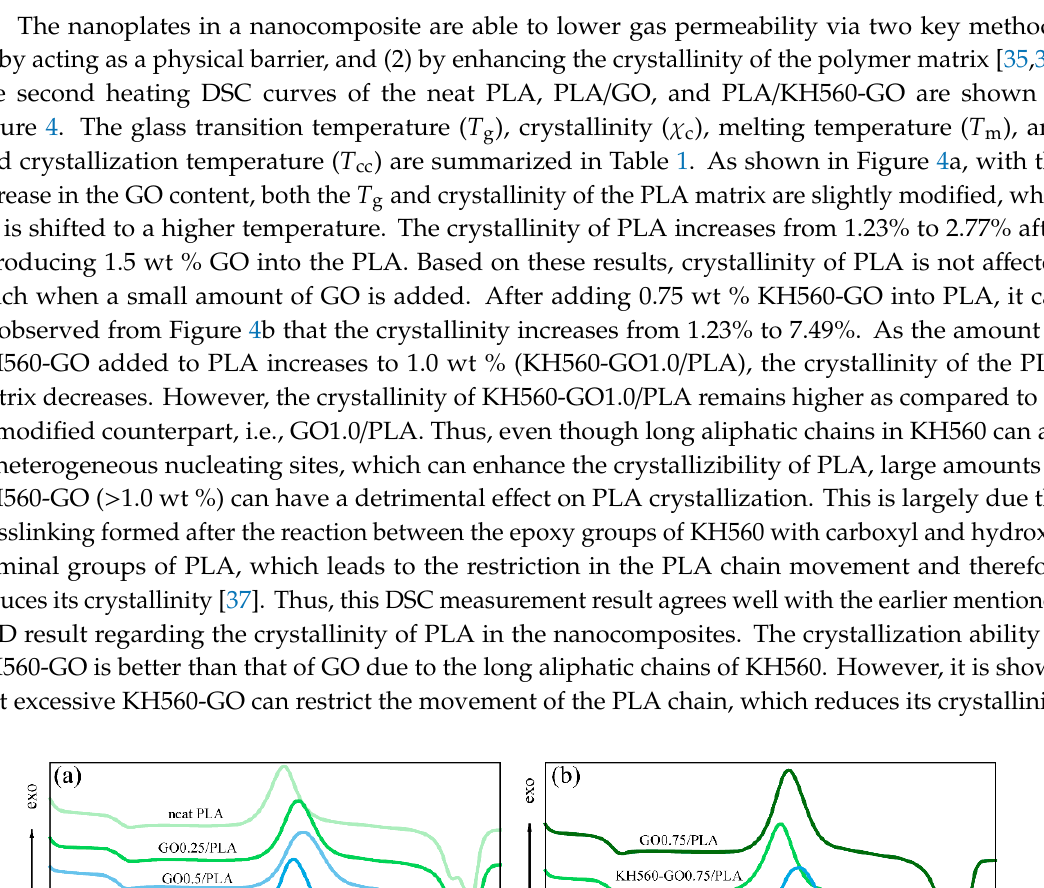
Figure 4. The glass transition temperature ( T g ), crystallinity ( χ c ), melting temperature ( T m ), and